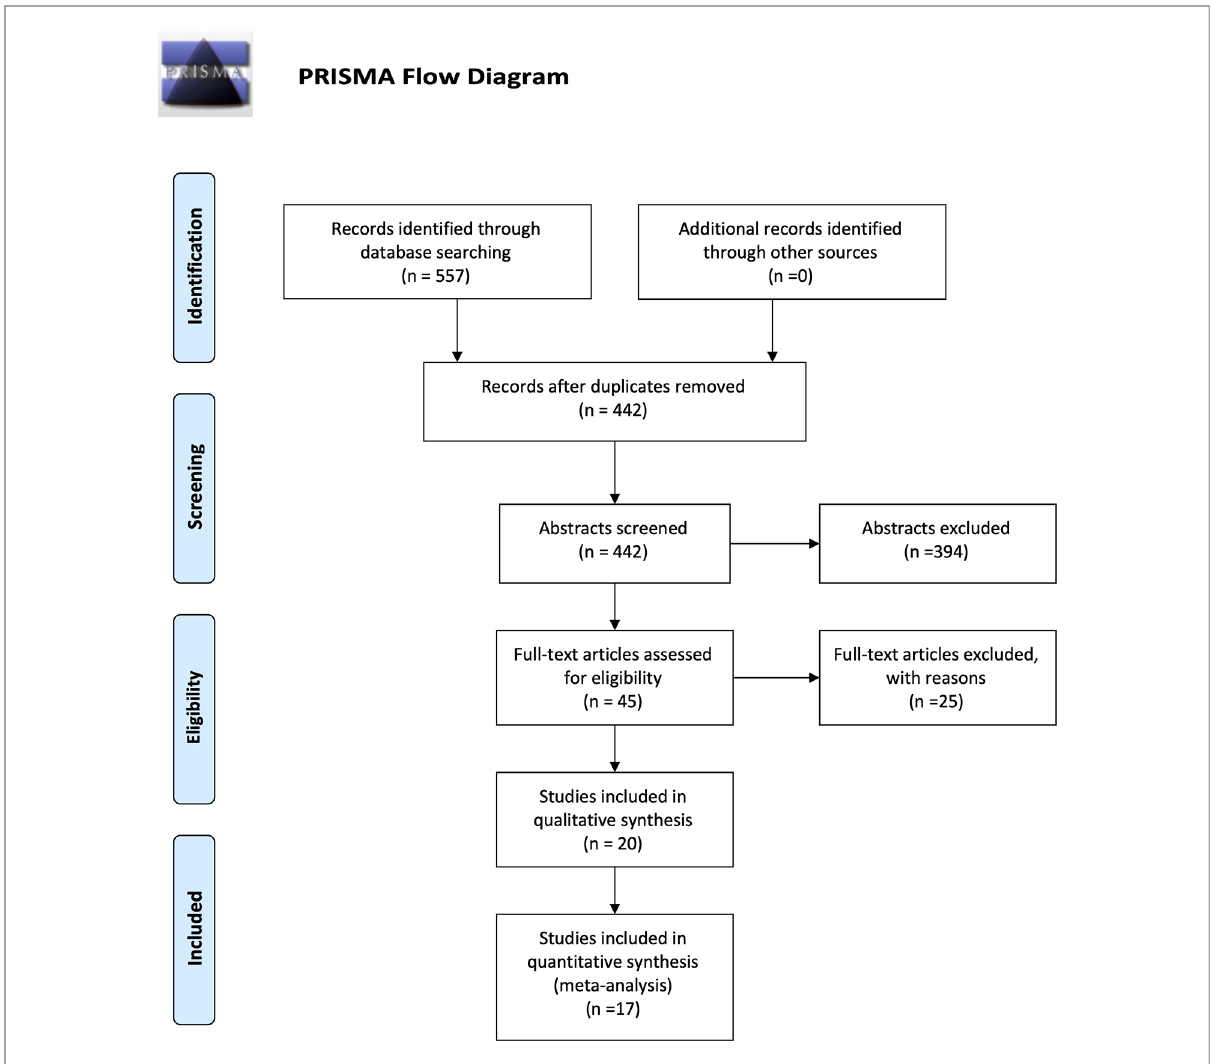
FIGURE 1 PRISMA fl ow diagram of the